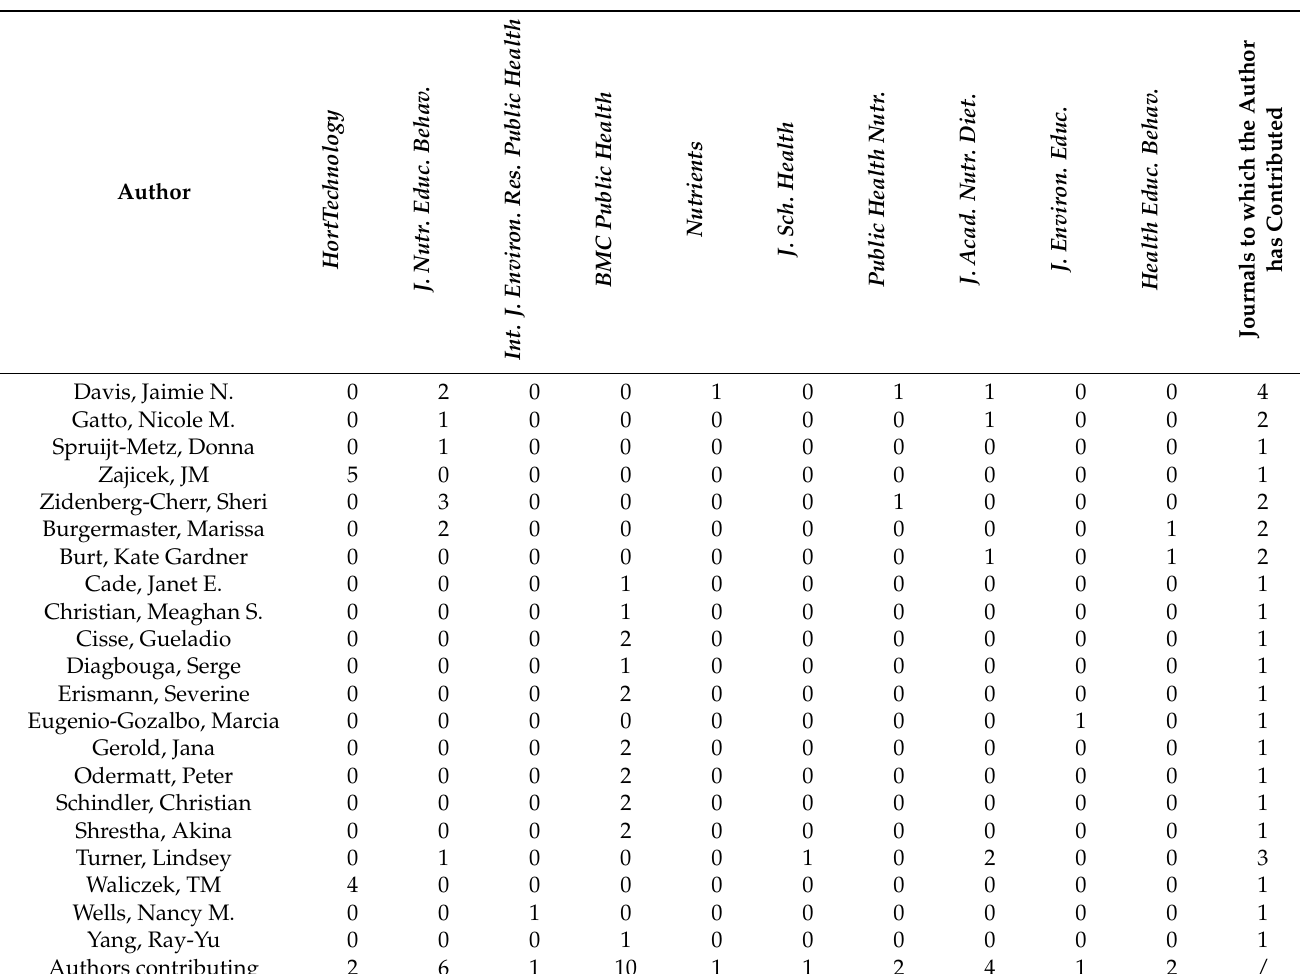
Table 4. Relationship between prolific authors and main journals on school